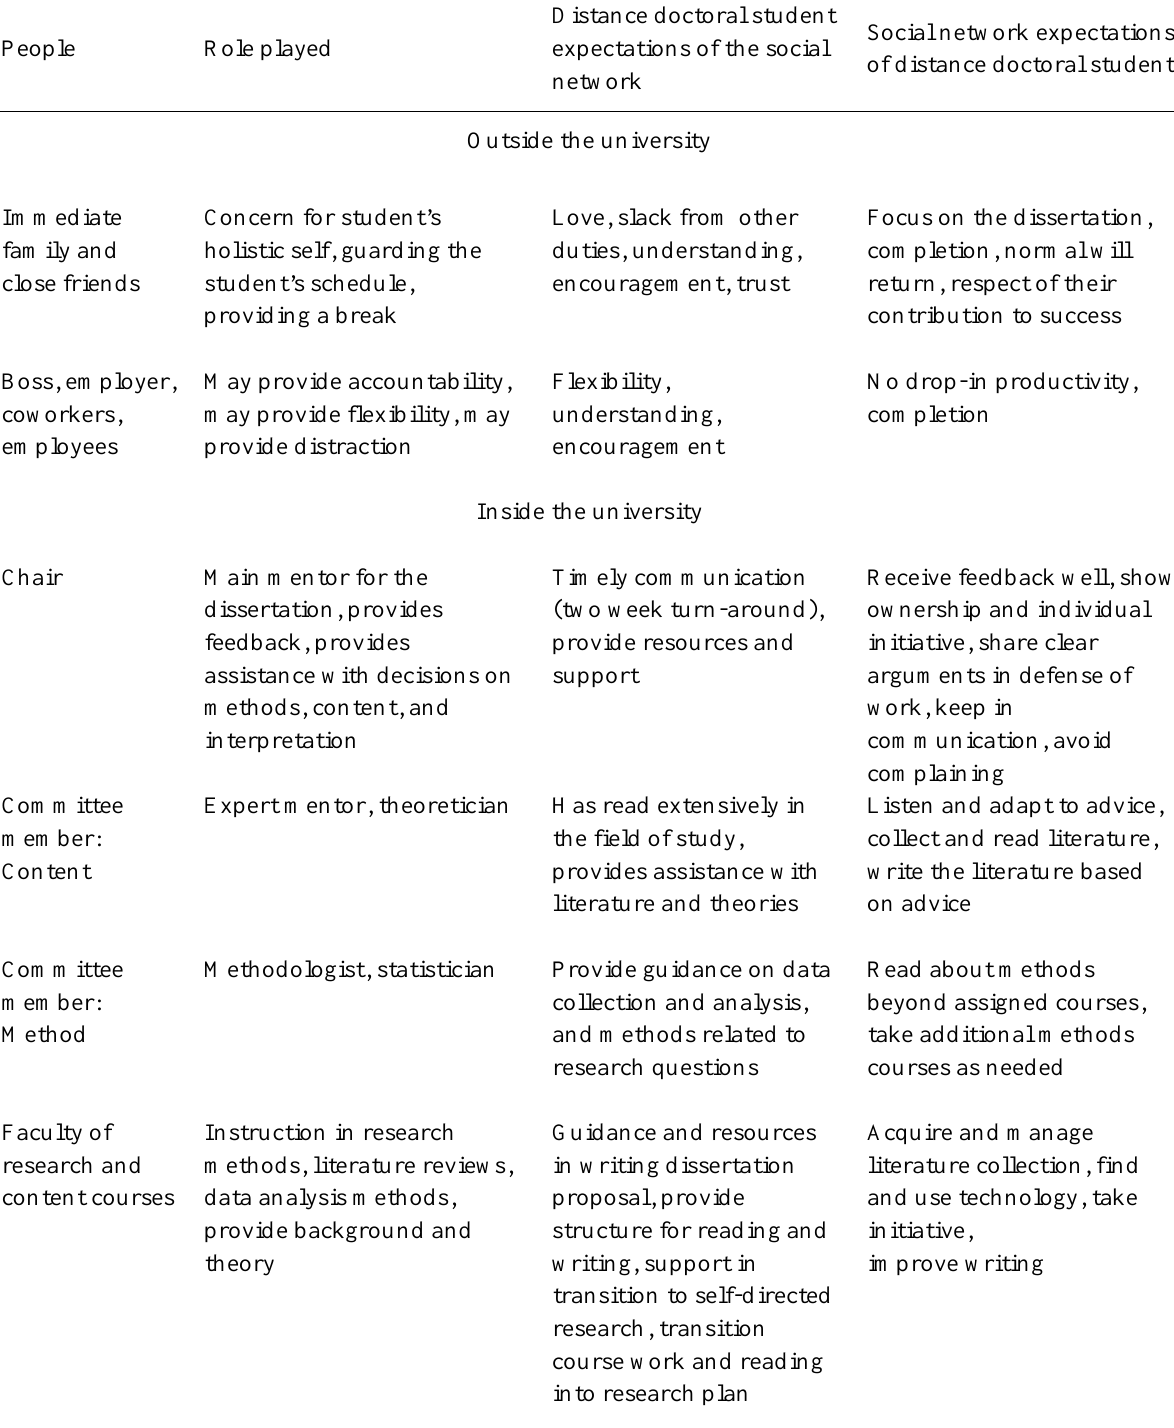
Table 2 Social Network and Role in the Dissertation